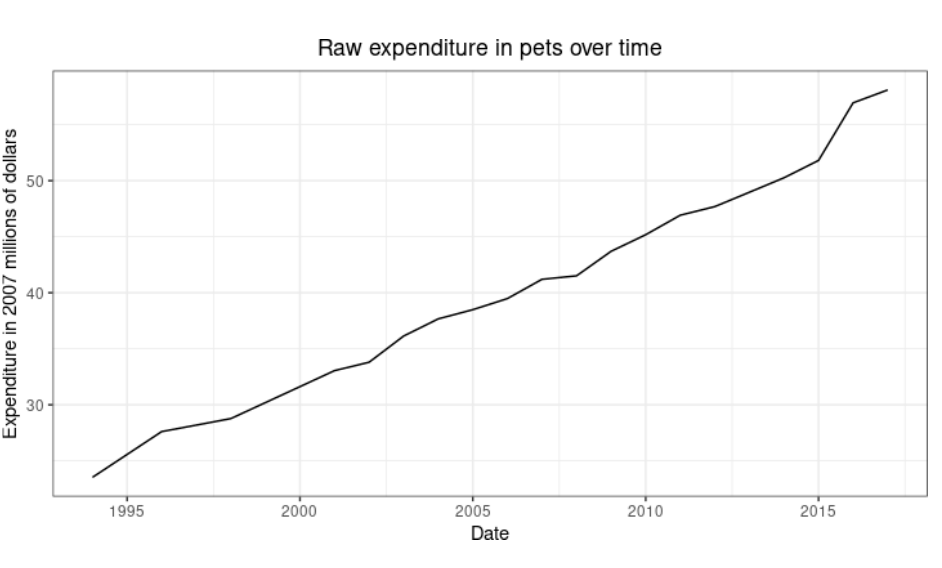
Figure 4. Pet Expenditures over time.